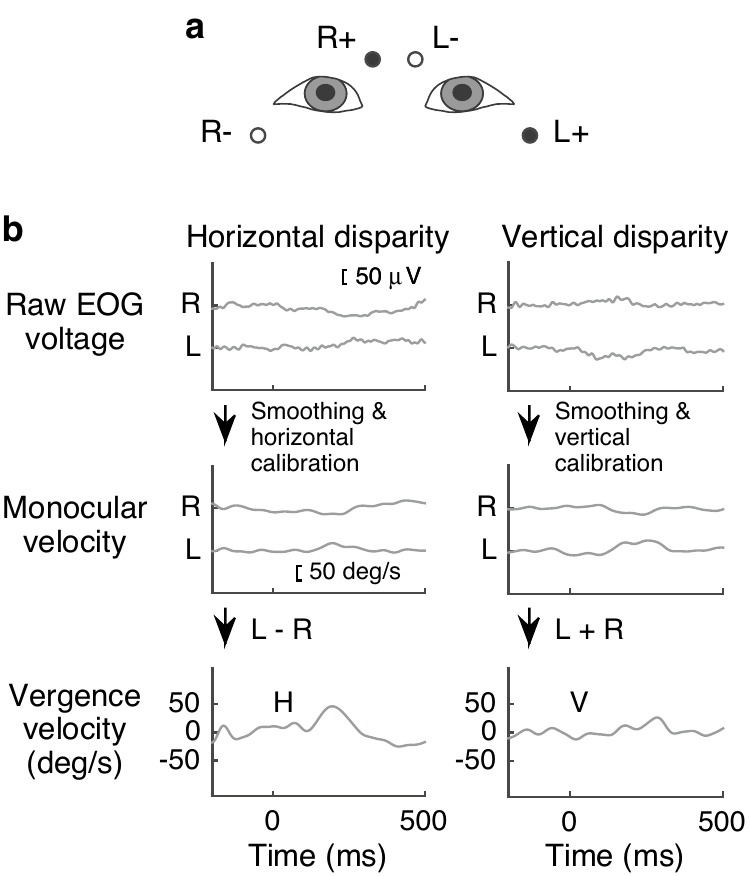
Figure 6. Calculation of vergence eye movements in a trial. ( a ) Approximate position of bipolar EOG electrodes for each eye. ( b ) Sequence of EOG data processing. Sample data are shown for a single trial from one subject separately for each disparity condition (left or right column). Raw voltage data (upper row) were transformed into velocity data (middle row). Vergence velocity was calculated by combining the two eyes’ data (bottom